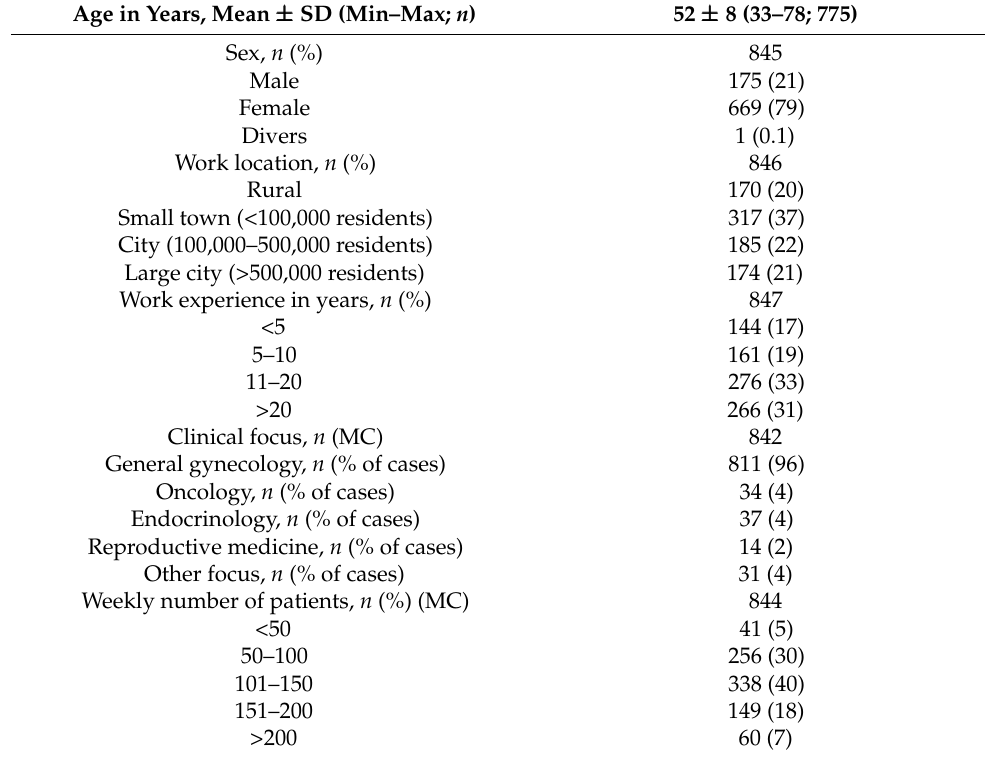
Table 1. Demographic